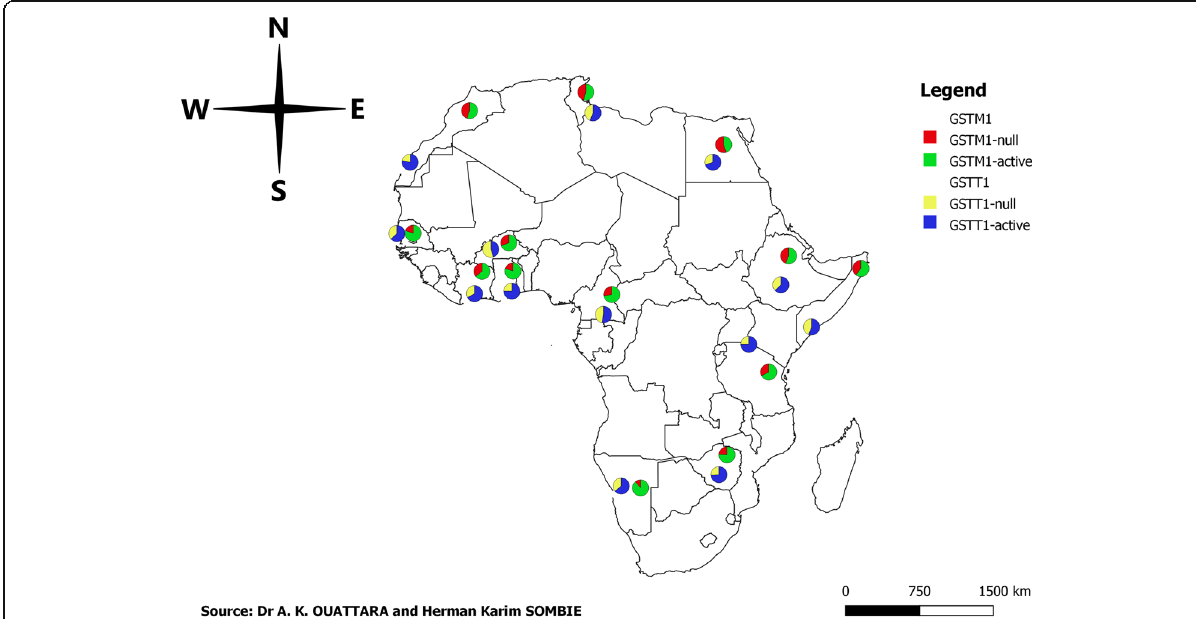
Fig. 1 GSTM1 and GSTT1 genes deletion frequency in African countries [37 – 46]. Legend : Pie charts show frequency of GSTM1-null (red) and GSTT1- null (yellow) frequency in each country